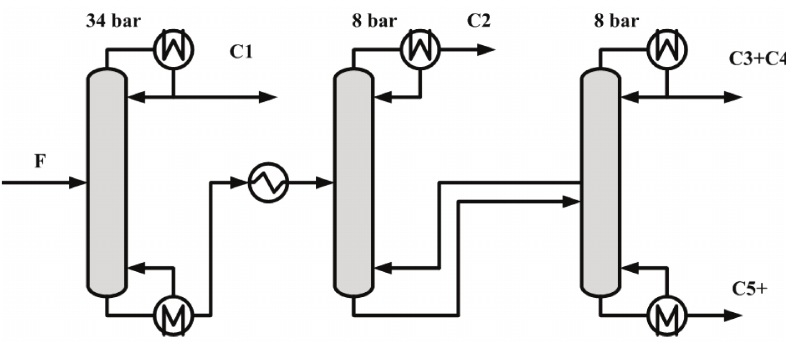
Fig. 1 – Conventional demethanizer & thermally coupled direct sequence (TCDS)